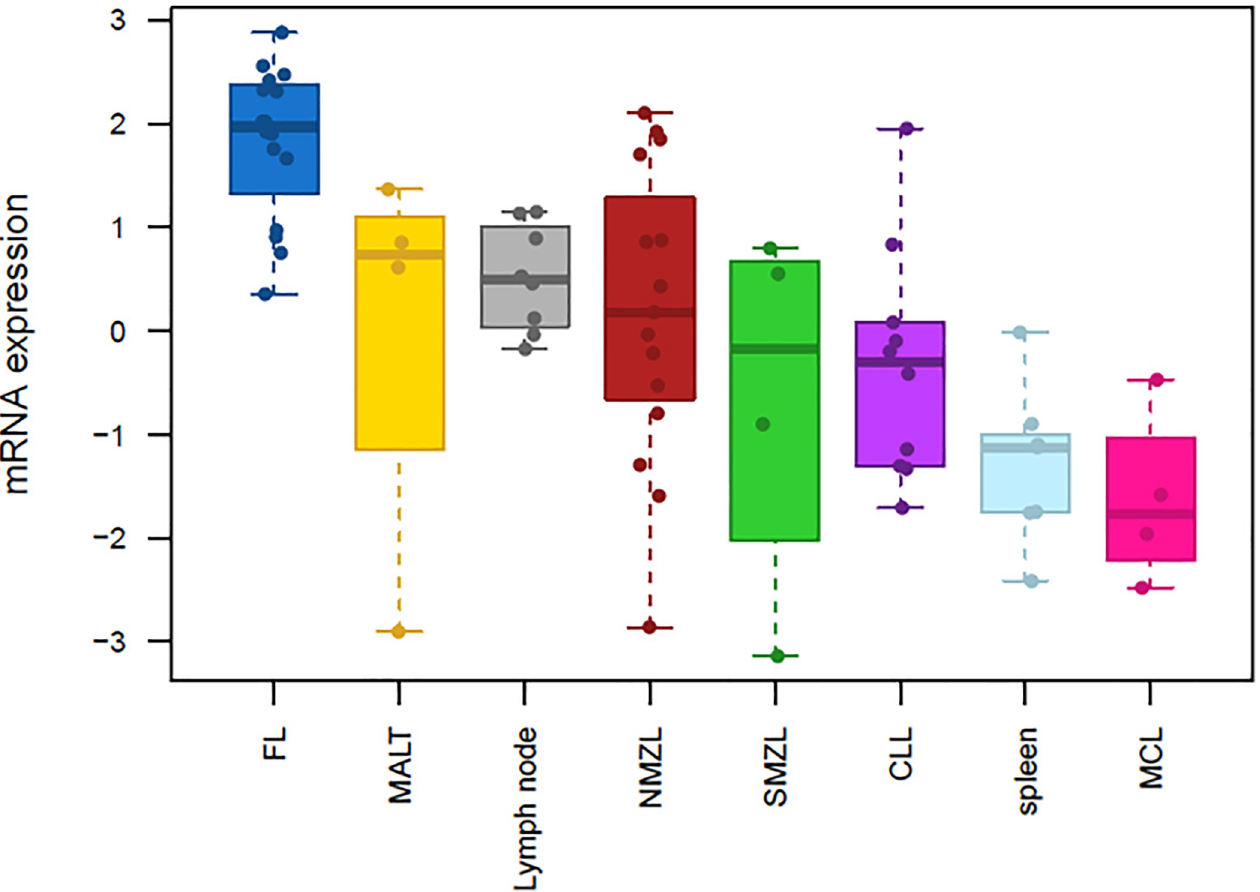
Fig 1. Boxplot on mRNA expression of TOX across low-grade B-cell lymphomas and reactive lymphoid tissues. Relative gene expression of TOX mRNA expression across B-cell lymphomas and lymphoid reactive tissues (n = 72): 16 lymph nodes with FL (blue), 4 lymph nodes infiltrated by MALT lymphoma (yellow), 8 reactive lymph nodes (grey), 15 lymph nodes with NMZL (red), 4 lymph nodes infiltrated by SMZL (green), 14 spleens infiltrated by CLL (light blue), 7 reactive spleens and 4 spleens infiltrated by MCL (magenta). Statistical significance was obtained when TOX expression in FL was separately compared to each of the other histotypes (FDR < 0.05, fold-change > 2.0. S1 Table in S1 Text). Expression data from each individual case is illustrated by single